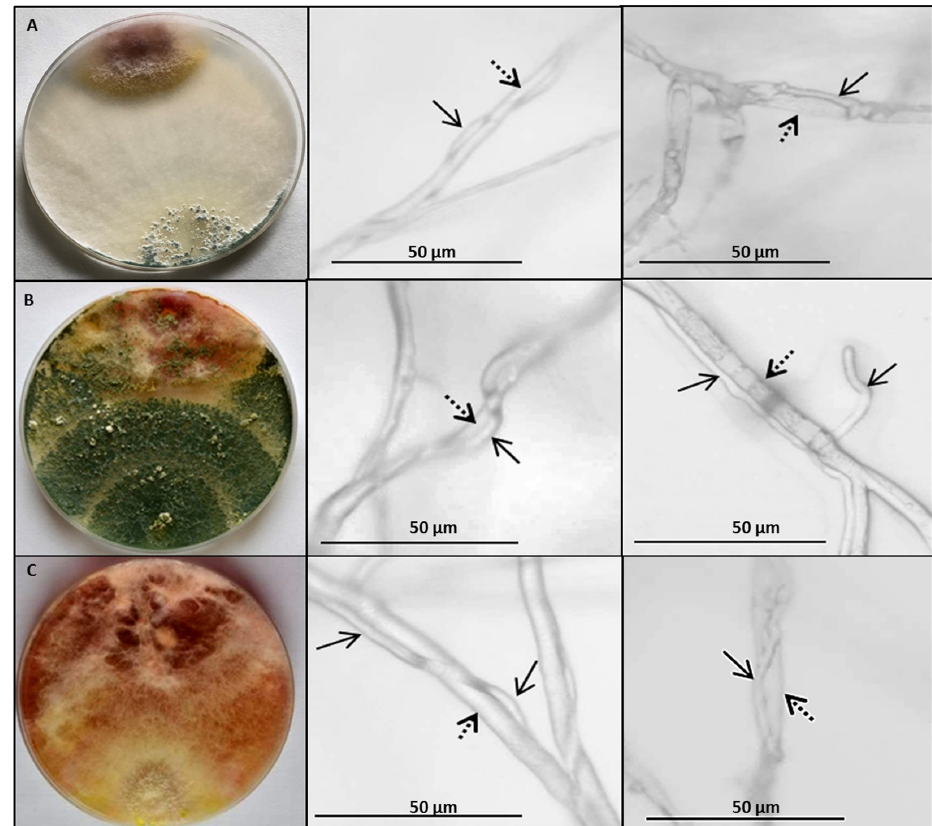
Figure 4. Interactions between F. culmorum KF846 and ( A ) T. viride AN430; ( B ) T. atroviride AN240; ( C ) C. rosea AN291 in dual cultures on a PDA medium. The left panel shows the growth of the path ‐ ogen and antagonist co ‐ cultured in Petri dishes, the middle panel shows microscopic observations of the contact zones of pathogen and antagonist after 7 days of co ‐ incubation and the right panel shows microscopic observations after 14 days of fungi co ‐ incubation. The dashed arrow points to the hyphae of F. culmorum KF846 and the solid arrow points to the hyphae of Trichoderma or Clonosta ‐ chys .